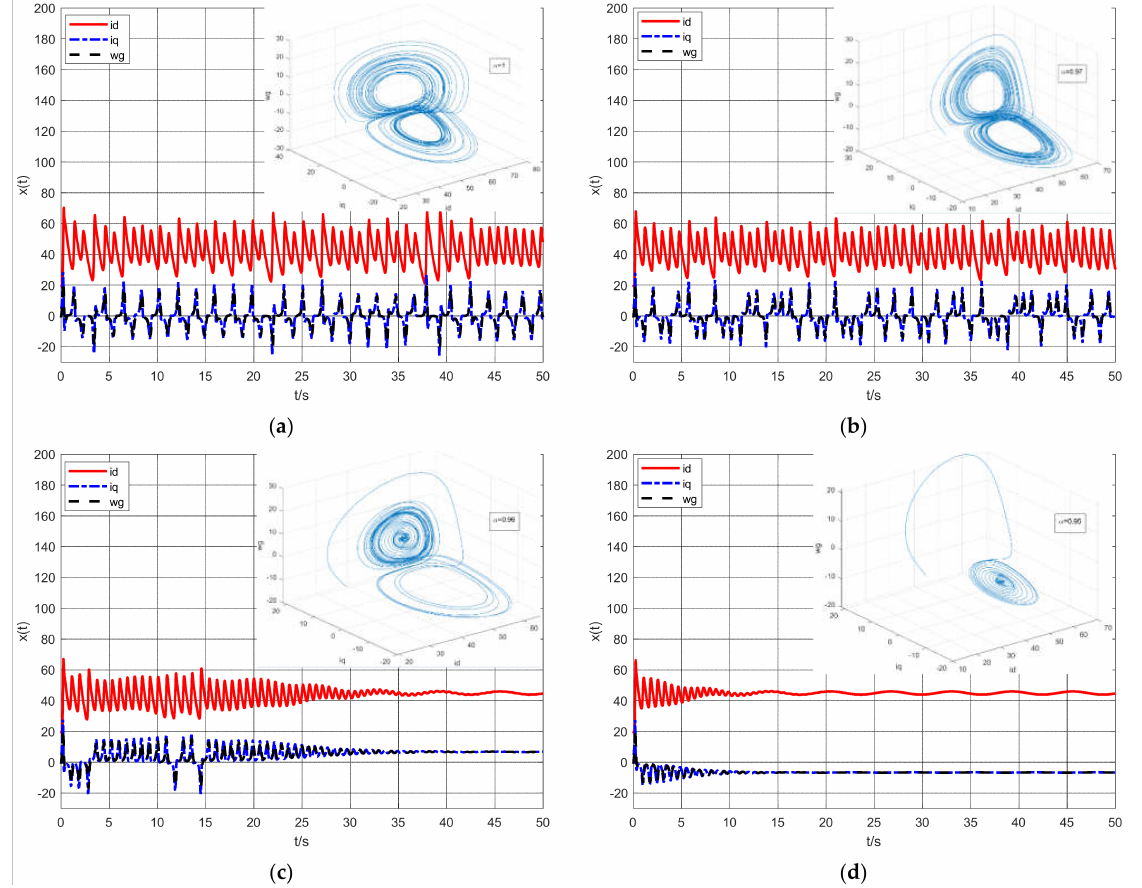
Figure 1. The chaotic characteristics of the system without